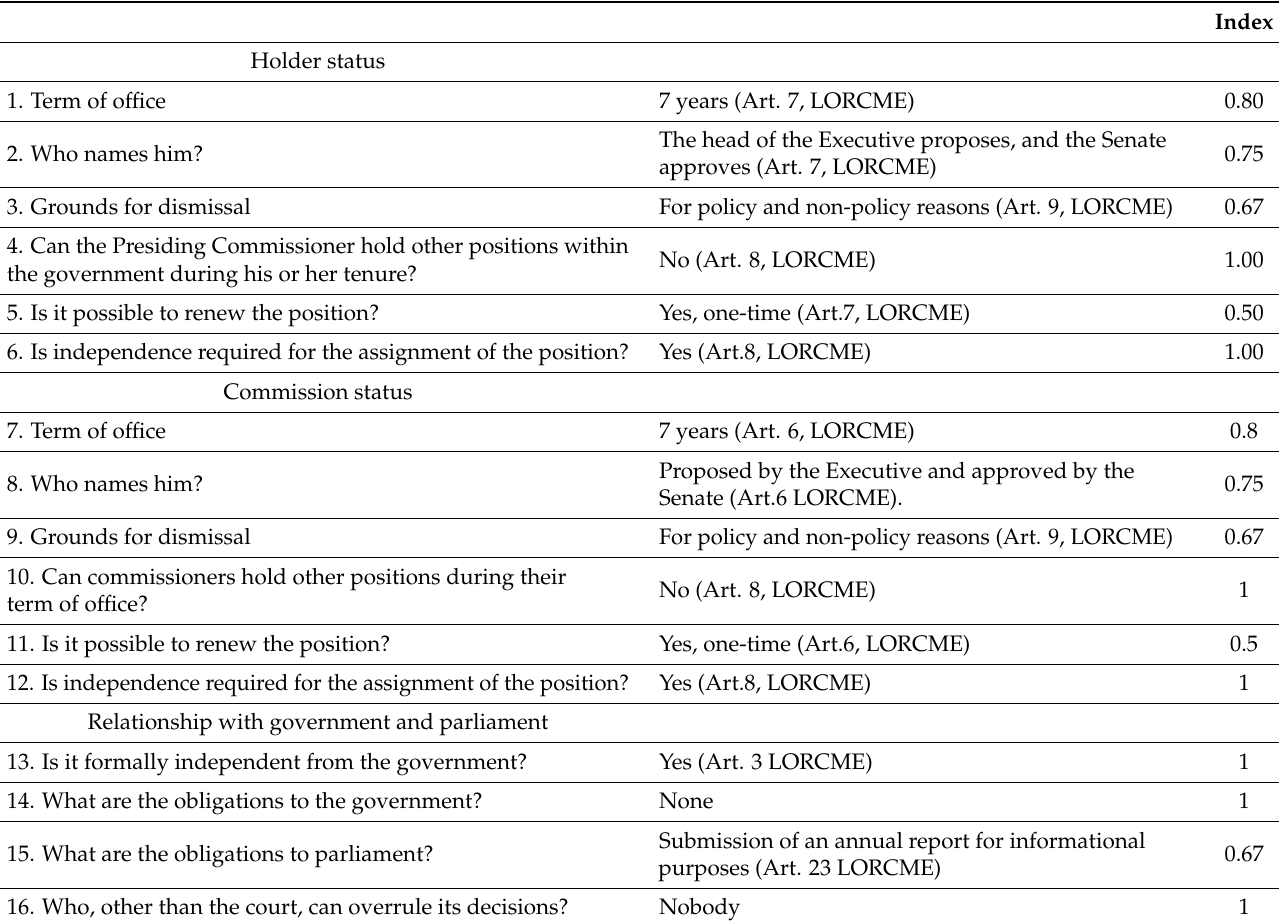
Table 6. Gilardi index applied to the CRE in